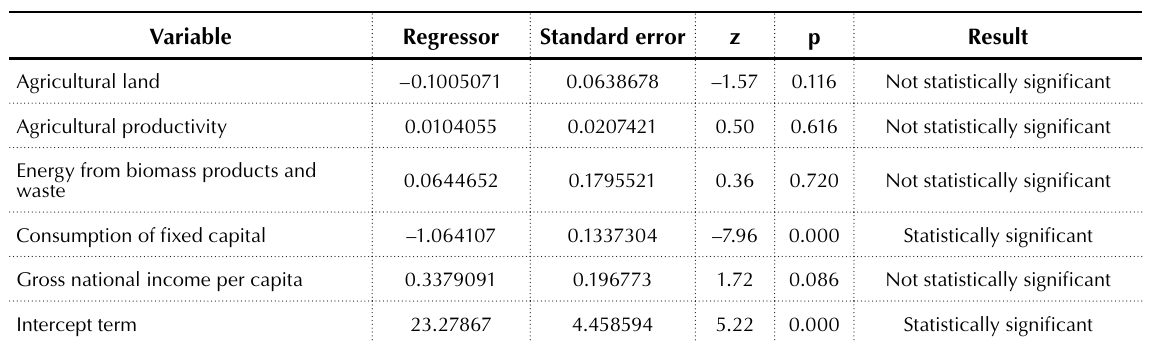
Table 6. Results of the regression model with random